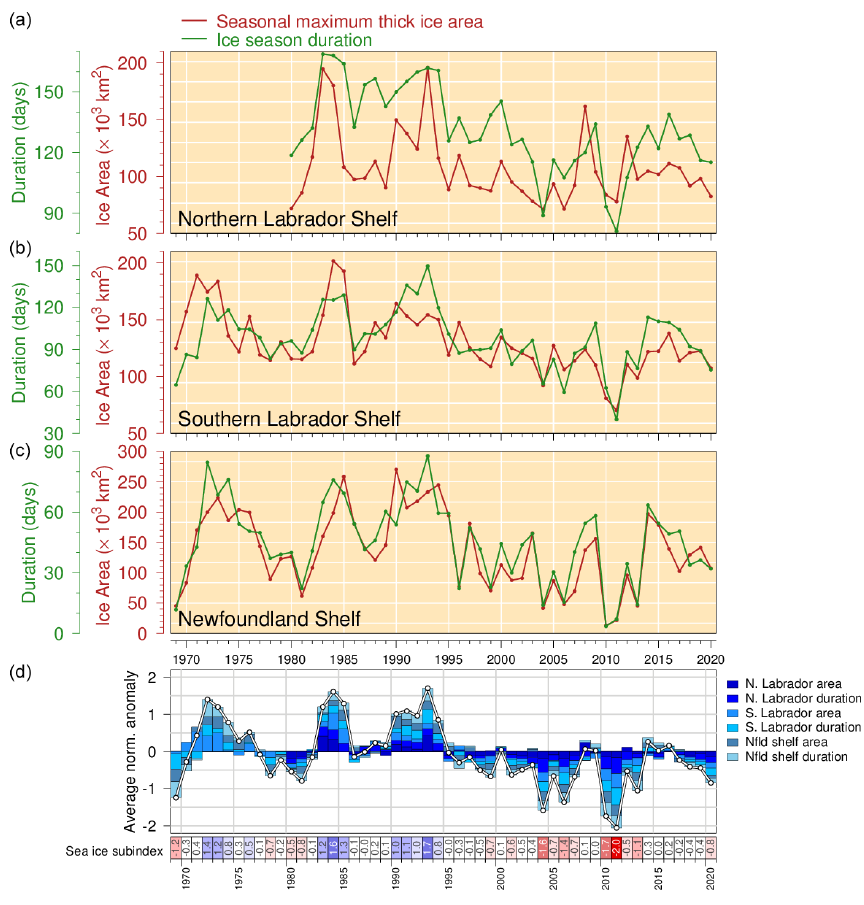
Figure A2. Same as Fig. 4 but using a climatology referenced to the 1981–2010 period.